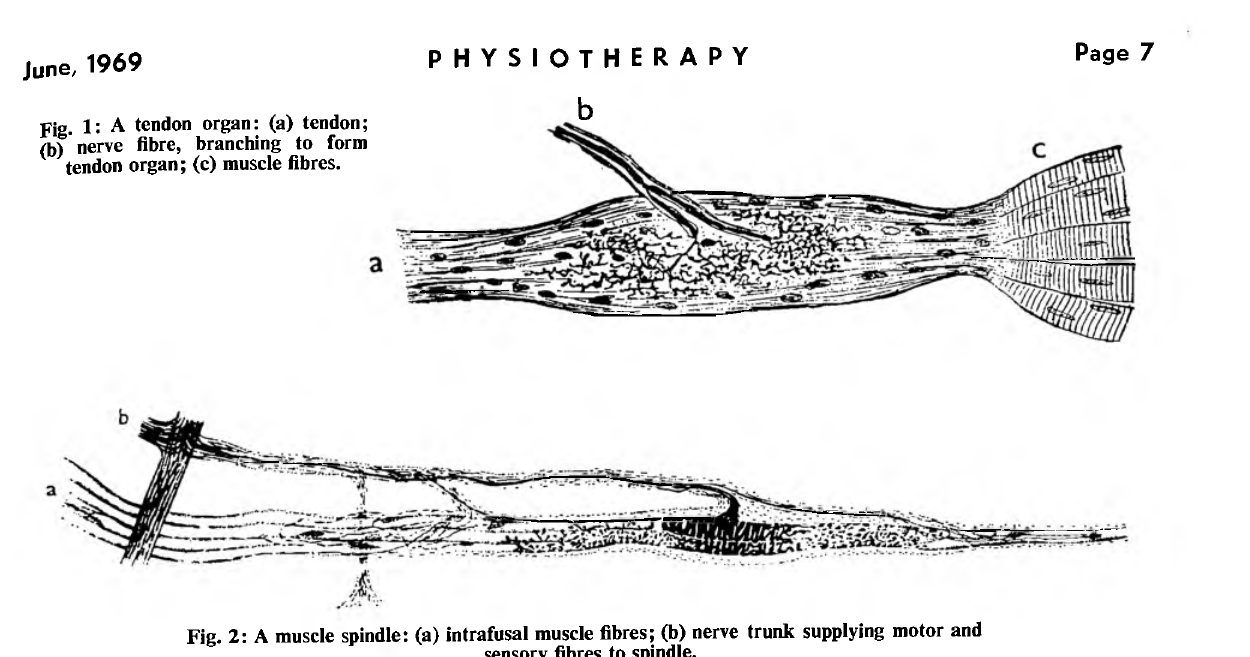
Fig. 1: A tendon organ: (a) tendon; (b) 'nerve fibre, branching to form tendon organ; (c) muscle fibres.